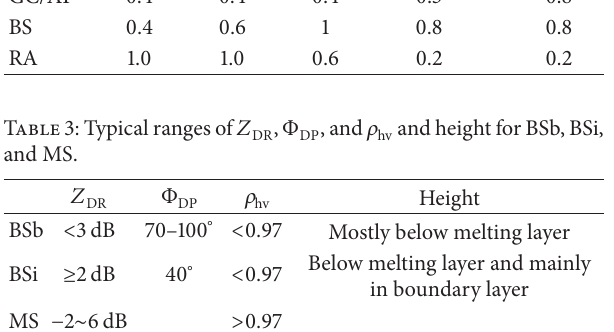
Table 2: Specified weights for the 5×3 membership functions in the simplified HCA.